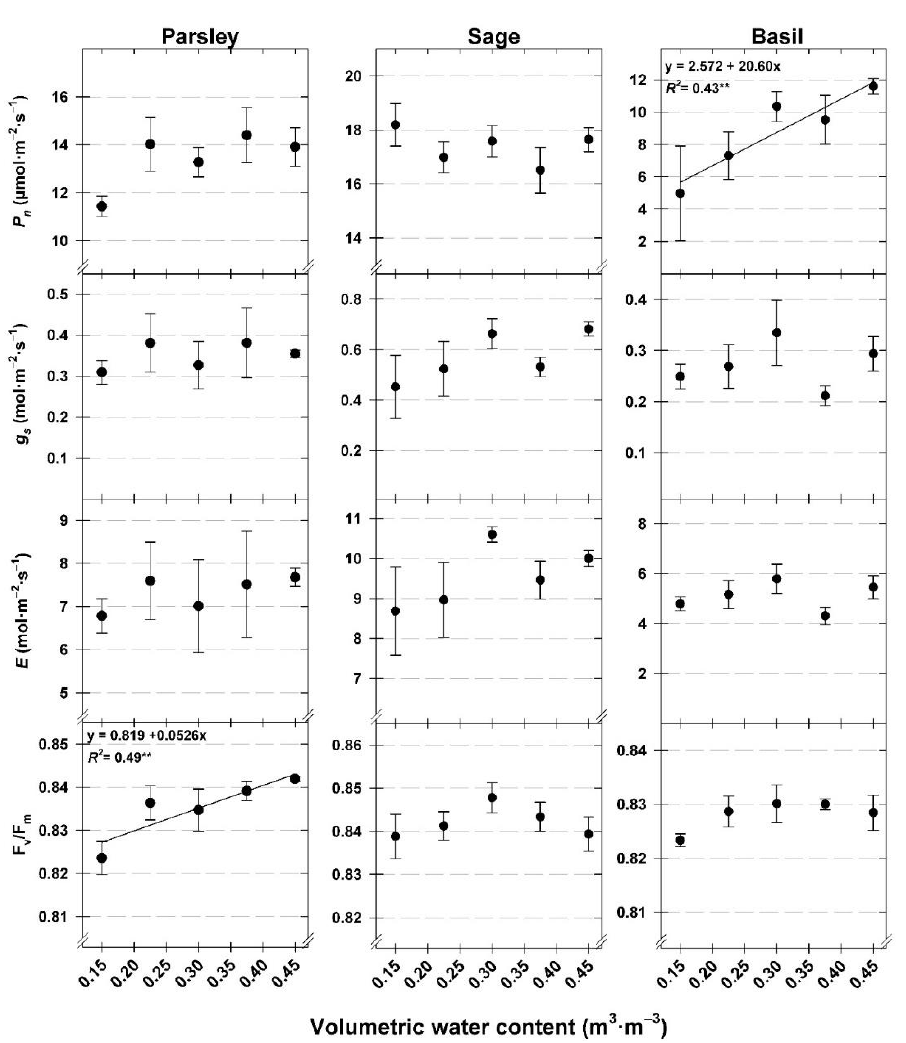
Figure 3. Photosynthesis ( P n ), conductance ( g s ), transpiration ( E ), and chlorophyll fluorescence ( F v / F m ) of parsley and sage (Expt. 1) and basil (Expt. 2) grown in 11.4 cm diameter containers filled with a soilless substrate comprising (by vol.) 75% sphagnum peat moss and 25% coarse perlite amended with 3.0 kg · m − 3 controlled-release fertilizer and maintained at 0.15, 0.23, 0.30, 0.38, or 0.45 m 3 · m − 3 substrate volumetric water content for four weeks. Regression lines are presented for significant correlations only with corresponding R 2 presented. ** indicates nonsignificant or significant at p ≤ 0.01.